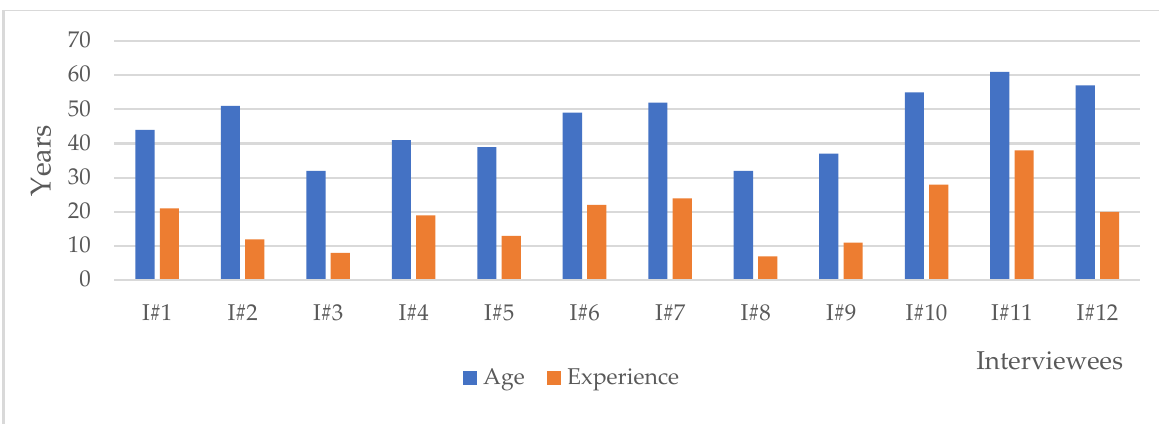
Figure 3. Age and experience. Source: authors.